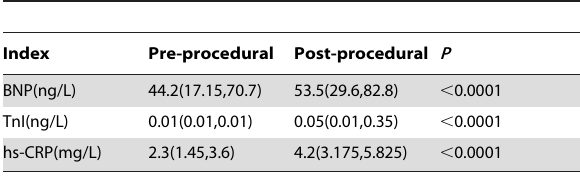
Table 4. Pre-post procedural levels of BNP, TnI and hs-CRP in conventional group(M(Q1,Q3)).